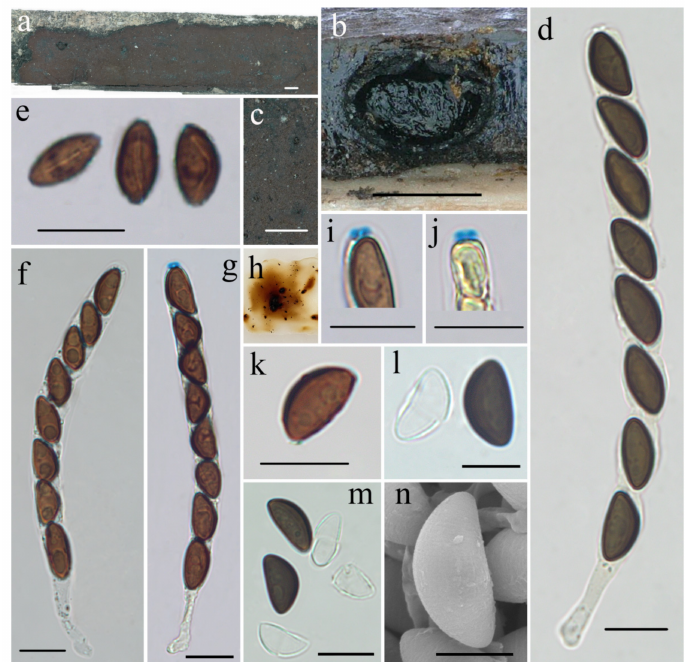
Figure 5. Hypoxylon wuzhishanense (holotype FCATAS 2708). ( a ) Stromata on dead Bamboo sp. ( b ) Stroma in vertical section showing the perithecia and tissue below the perithecial layer. ( c ) Stro- matal surface and ostioles. ( d ) Ascus in 10% KOH. ( e ) Ascospores in Melzer’s reagent showing germ slit. ( f ) Ascus in water. ( g ) Ascus in Melzer’s reagent. ( h ) KOH-extractable pigments. ( i , j ) Apical apparatus in Melzer’s reagent. ( k ) Ascospore in water. ( l , m ) Ascospore in 10% KOH. ( n ) Ascospore under SEM. Scale bars: ( a ) = 1 mm; ( b , c ) = 200 µ m; ( d – g , i – m ) = 10 µ m; ( g ) = 5 µ m. MycoBank: MB